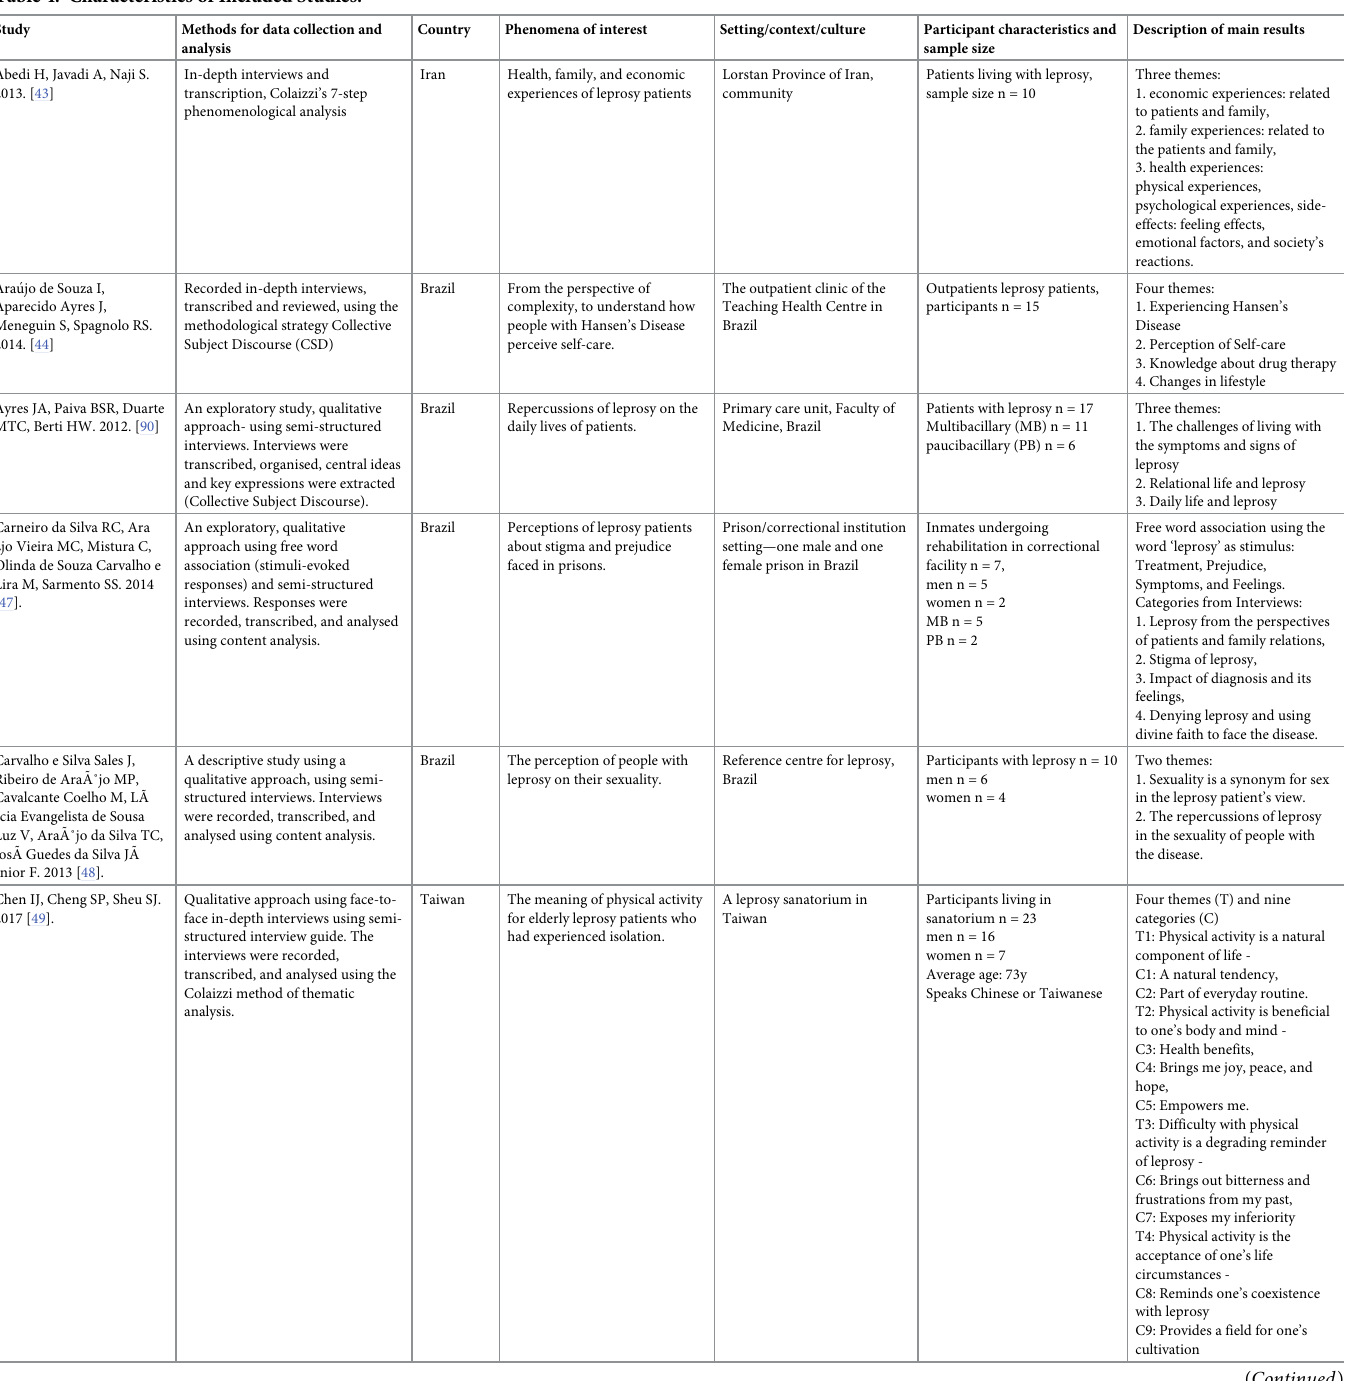
Table 4. Characteristics of Included